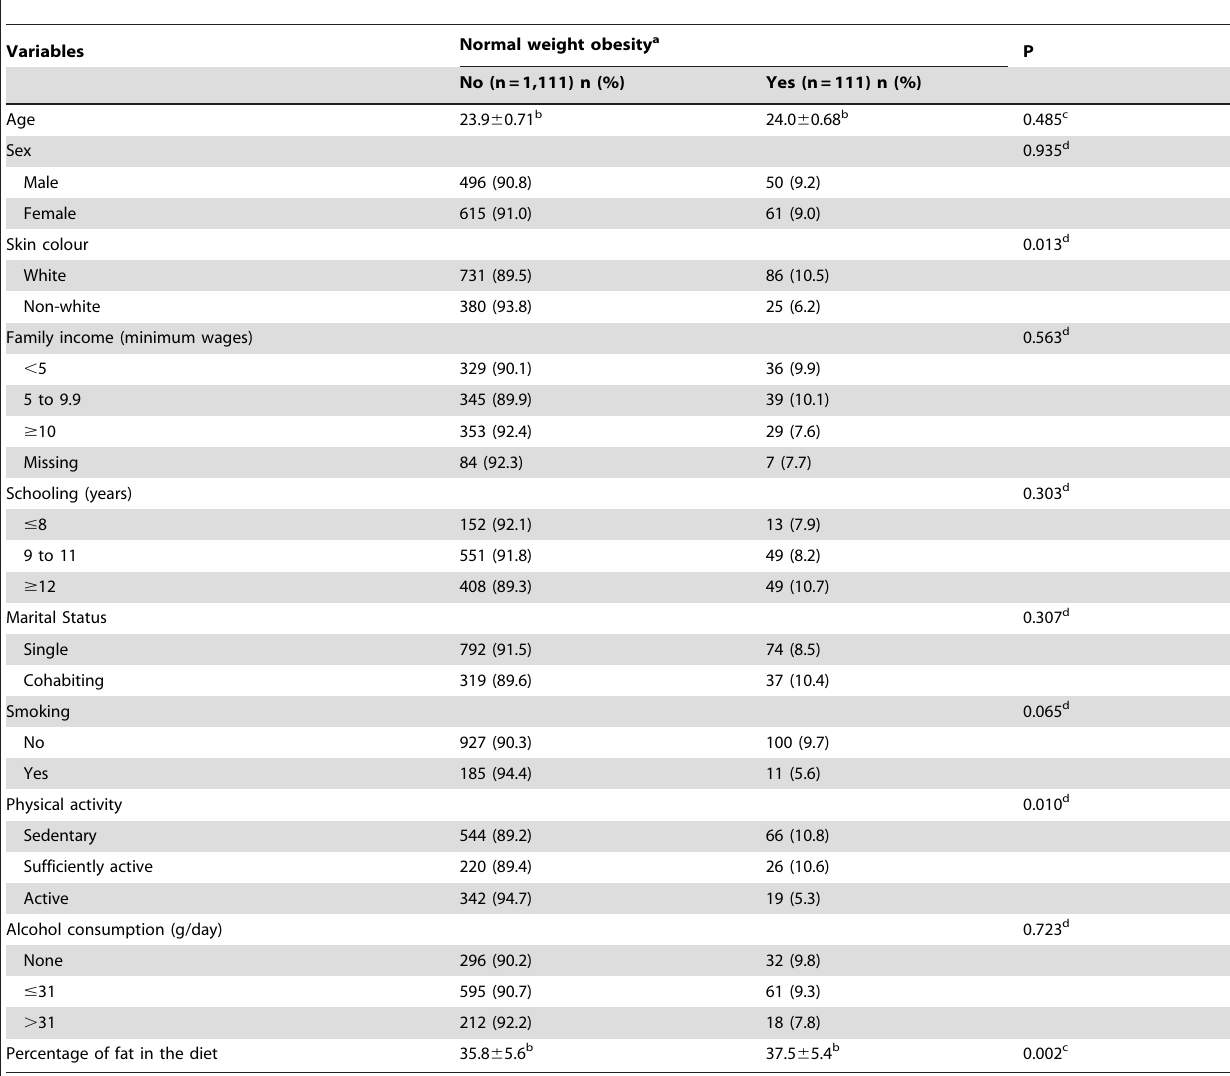
Table 3. Normal weight obesity according to adult life variables, 1978/79 Ribeira˜o Preto birth